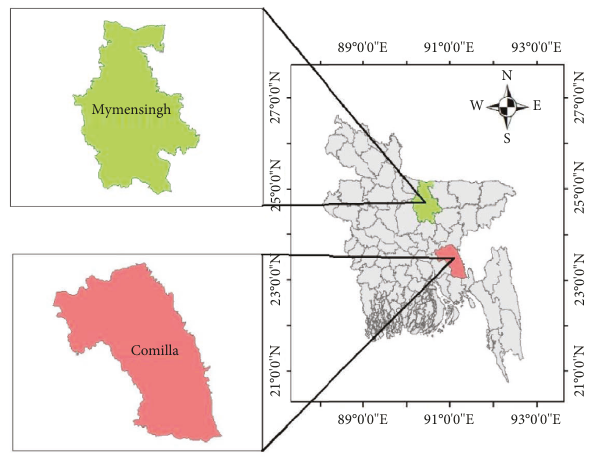
Figure 1: Location map of the study